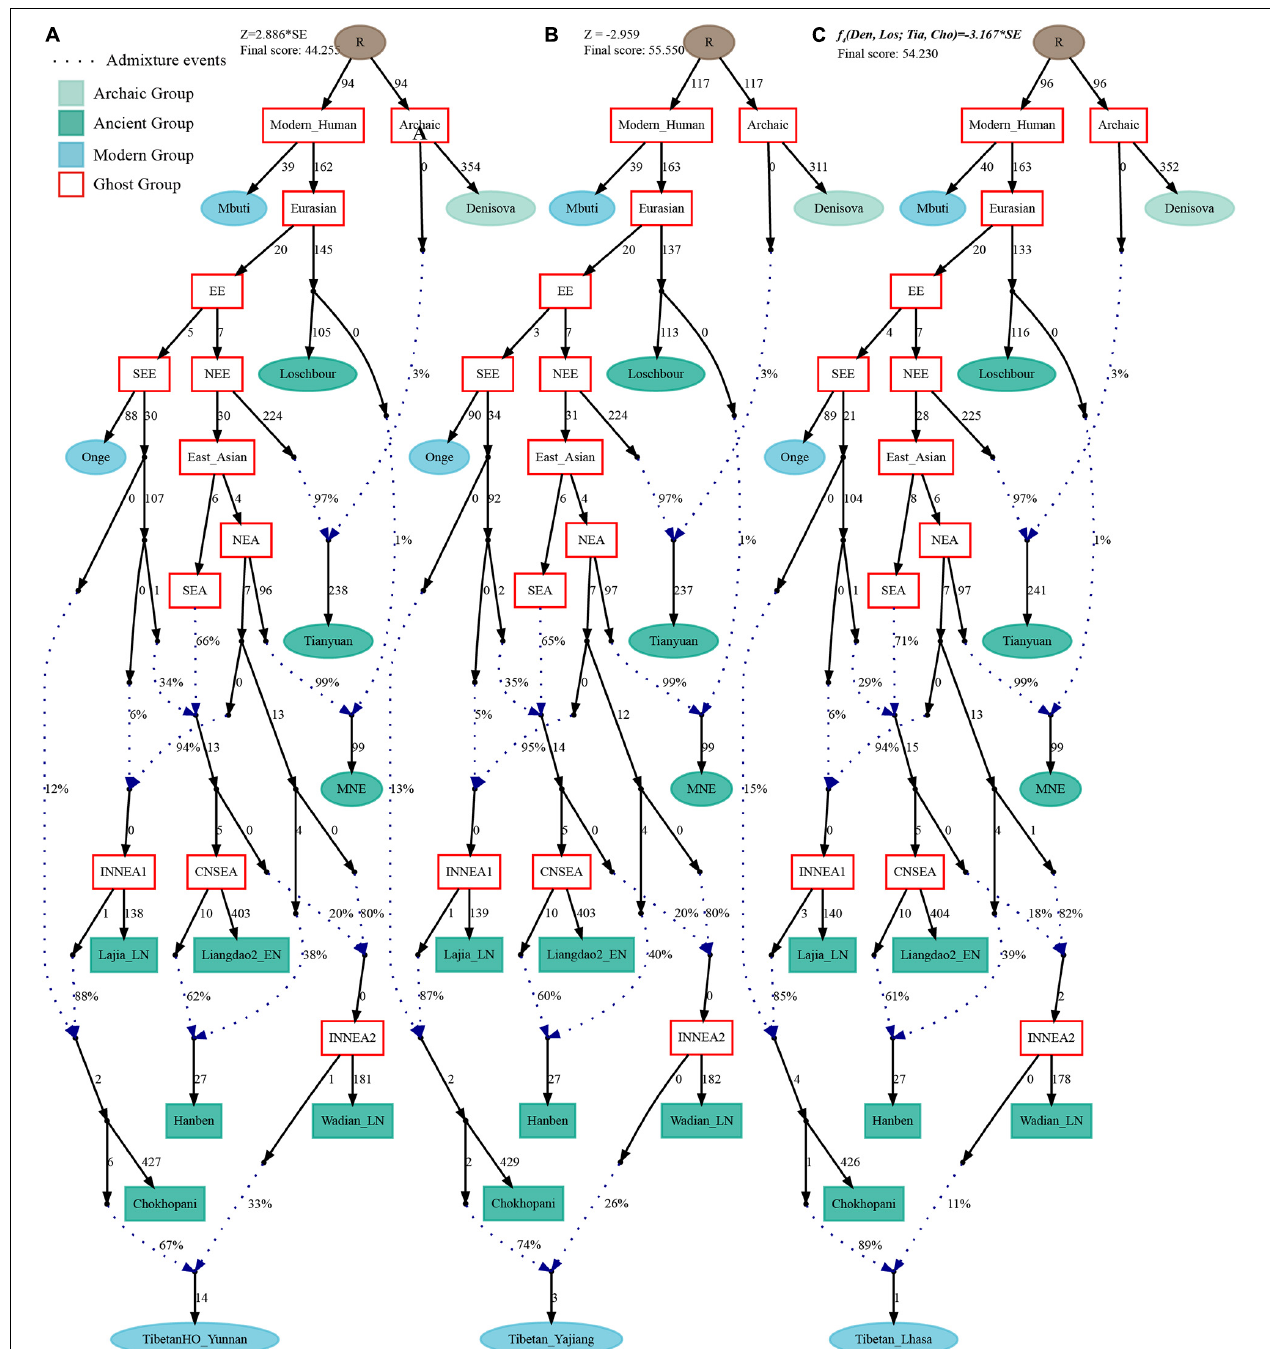
FIGURE 9 | Admixture graph model of modern highland and lowland Tibetans based on the Human Origin dataset using Late-Neolithic Wadian people as the source of the second migration into Tibetan Plateau. Admixture history of lowland Tibetan from Yunnan (A) , Tibetan from Yajiang (B) , and highland Tibetan from Lhasa (C)